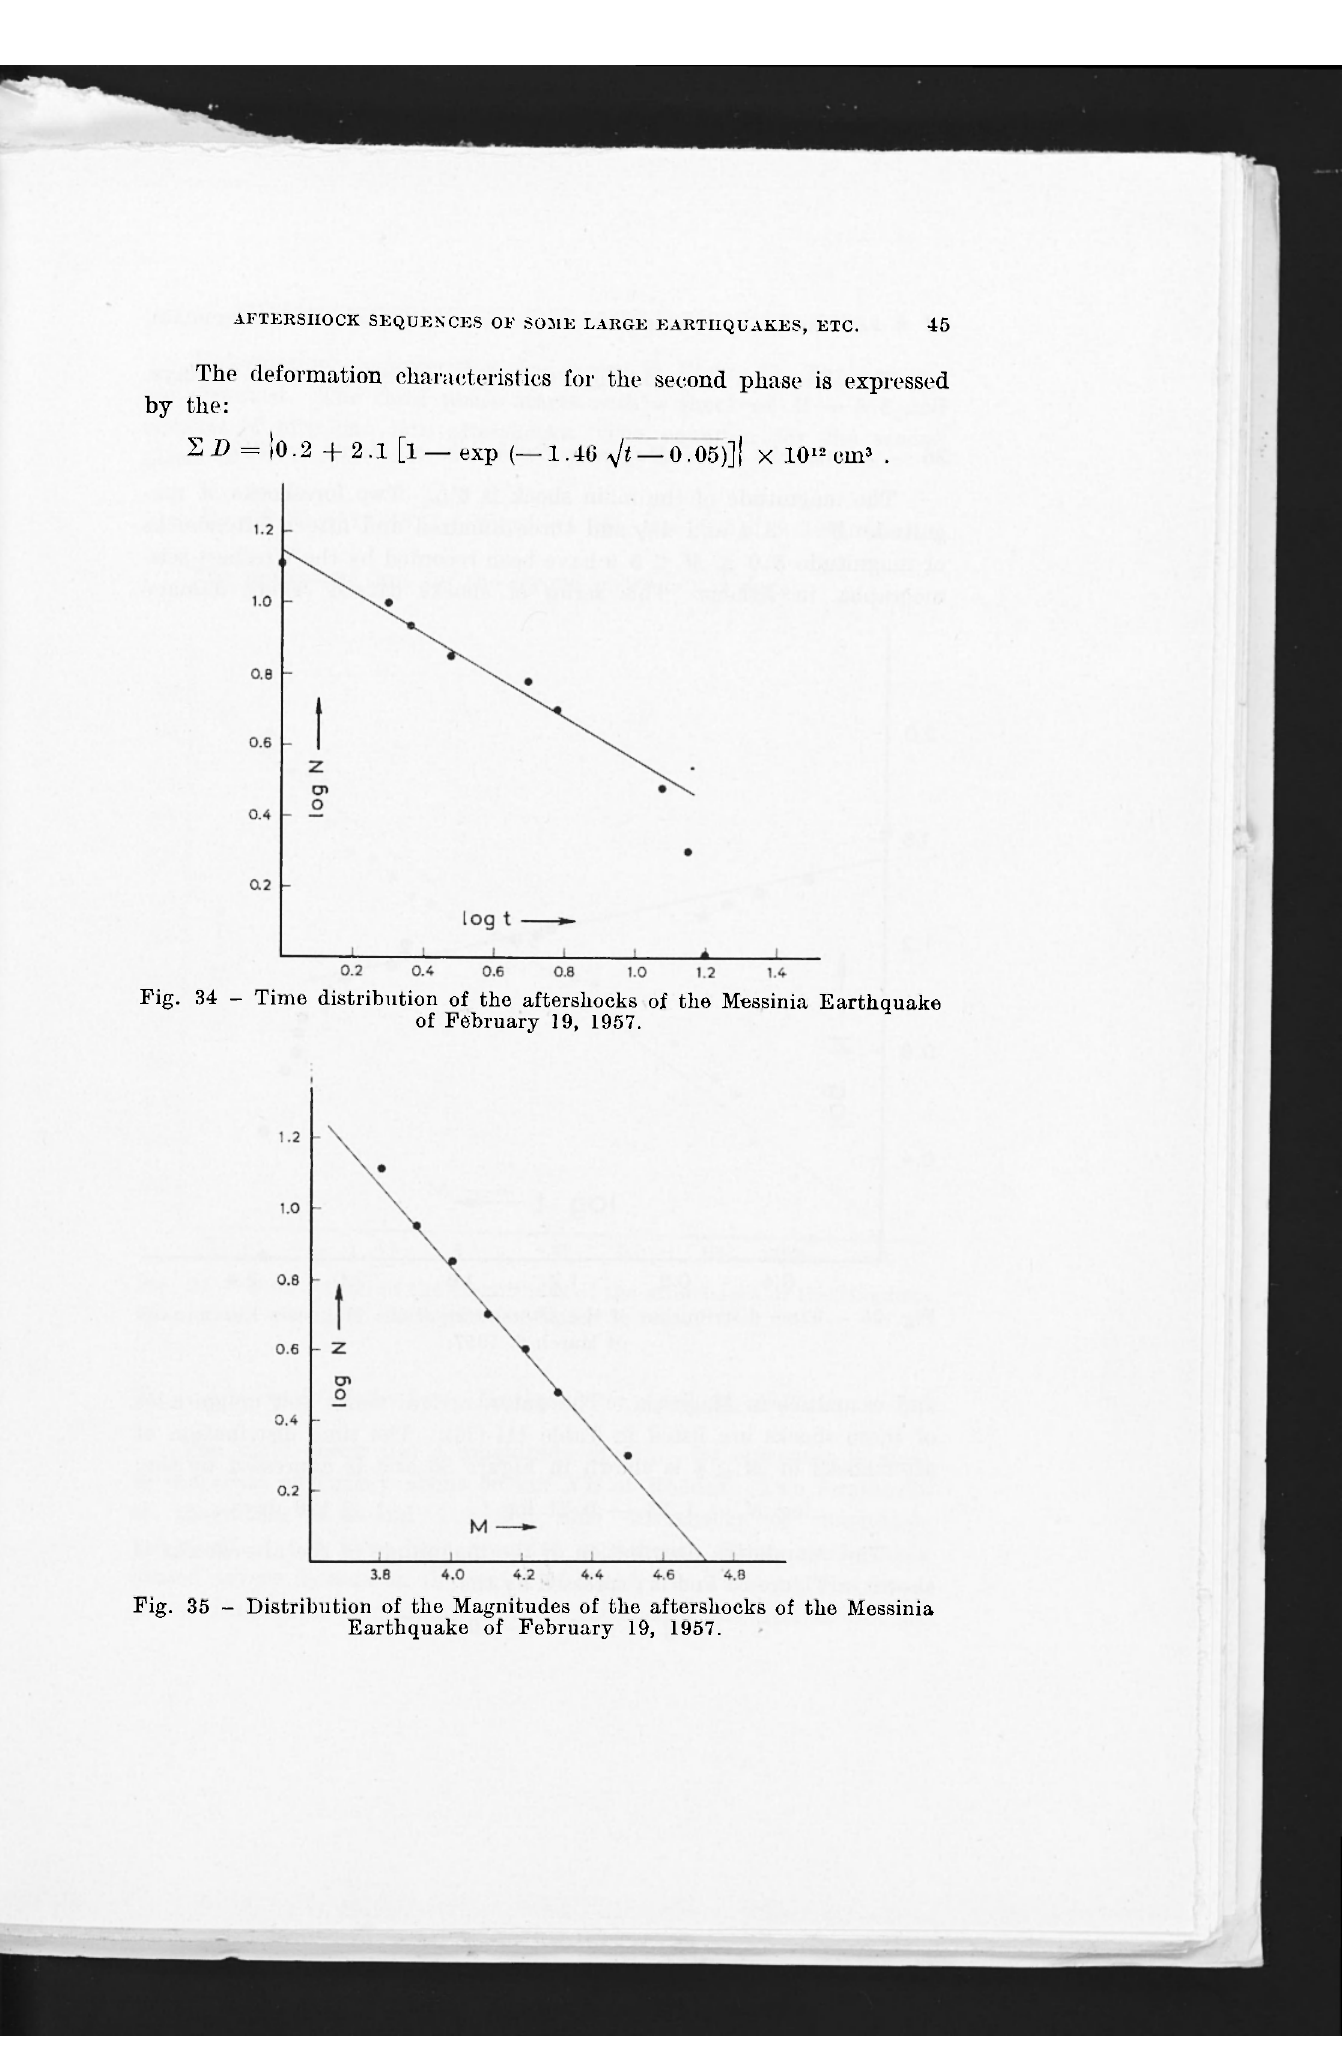
Fig. 34 - Time distribution of the aftershocks of the Messinia Earthquake of February 19, 1957.